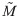
A triangular fuzzy number M˜.